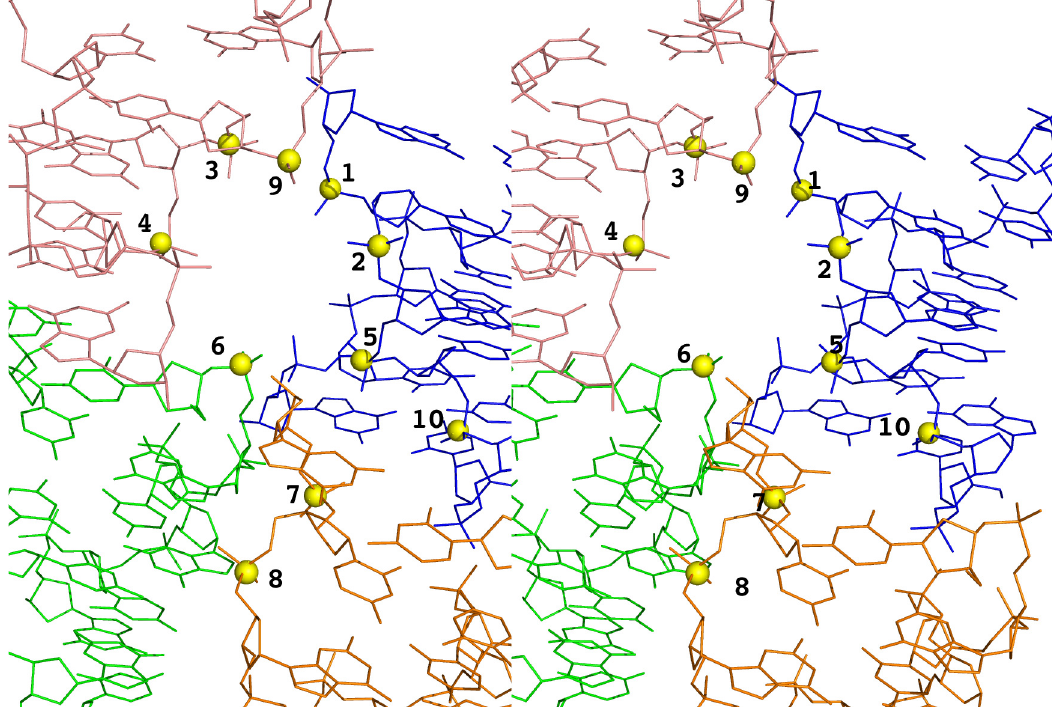
Figure 4. Patterson superposition minimum function (PSMF) peaks superimposed onto the refined Z-DNA structure shows that the peaks do not fall on a single molecule.